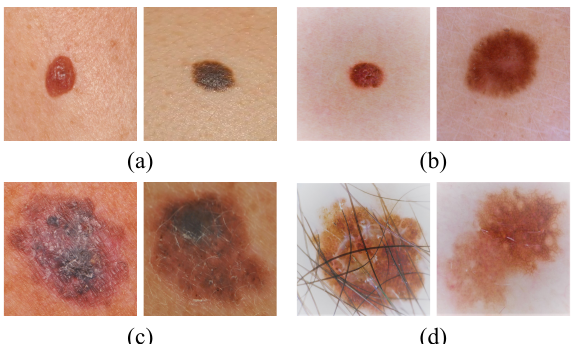
Figure 1. Melanoma images. ( a , c ) simple images and ( b , d ) dermatological images. ( a , b ) benign melanoma cases, and ( c , d ) malignant melanoma cases.